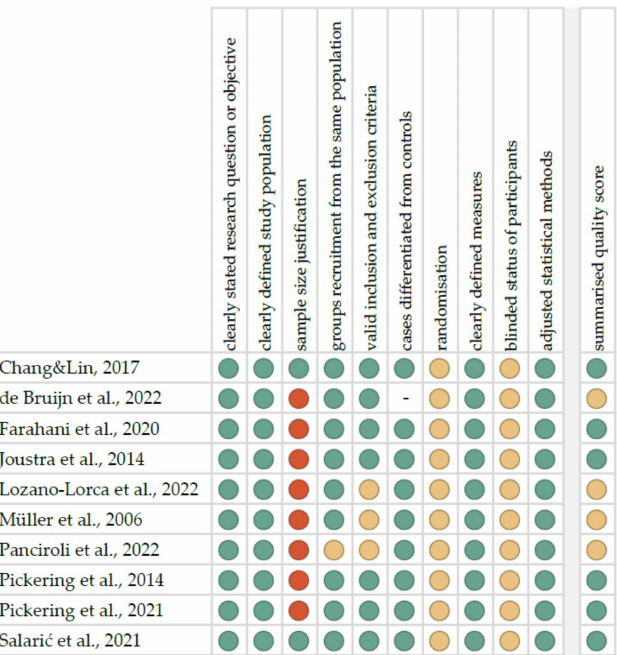
Figure 2. Quality assessment, including the main potential risk of bias (risk level: green—low, yellow— unspecified, red—high; quality score: green—good, yellow—intermediate, red—poor)